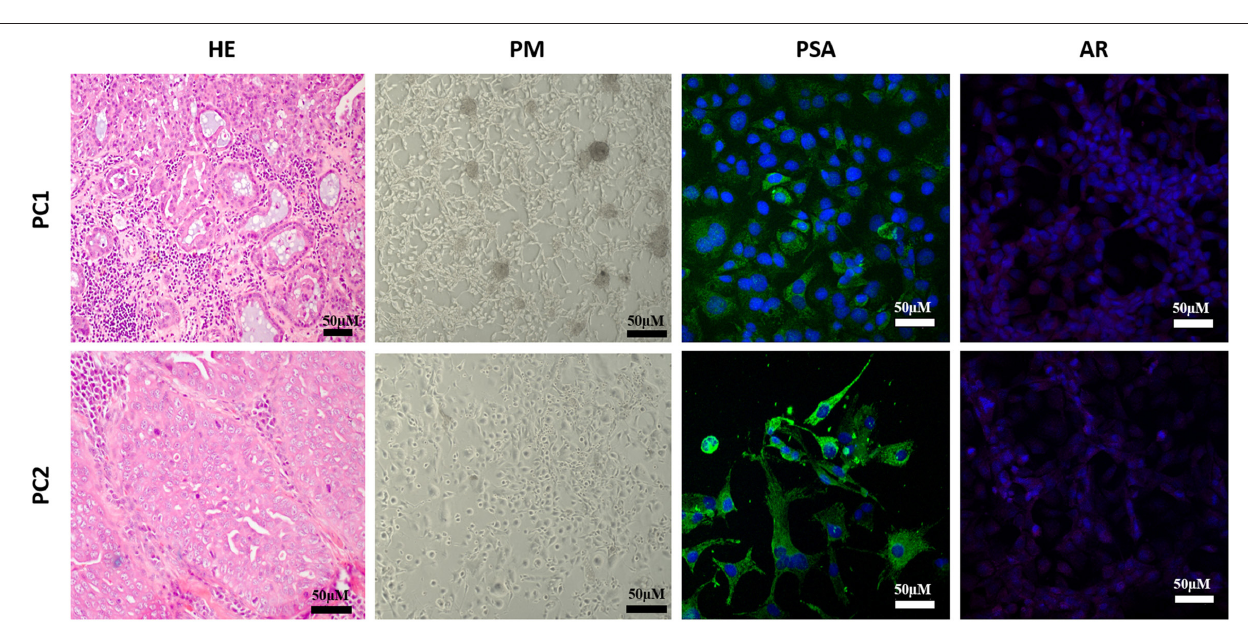
FIGURE 1 | Peak generated in the mass spectrum (HRMS) of the latex of Synadenium grantii by magnifying the general chromatogram and its respective structures, molecular forms, and fragment masses. Chromatograms: (A) m/z 313.17; (B) m/z 265.02; (C) m/z 277.02 and 295.03. Structure, molecular form, and fragment mass: (D) m/z 265.02; (E) m/z 277.02; (F) m/z 295.03; and (G) m/z 313.17.